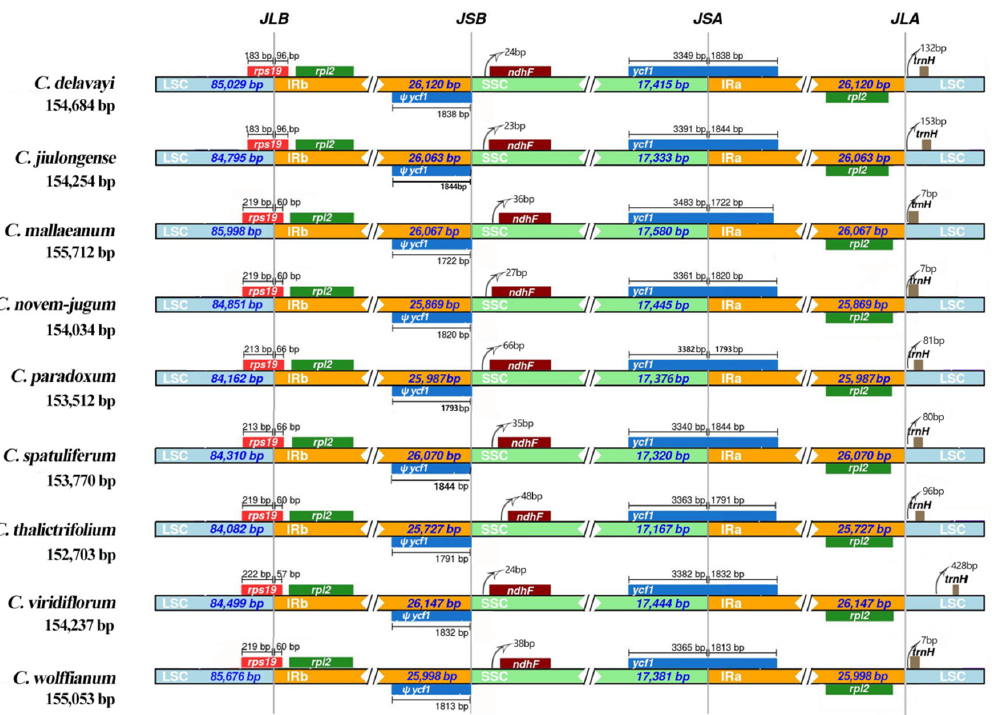
Figure 3. Comparisons of LSC, SSC and IR region borders among nine Chamaesium plastid genomes.